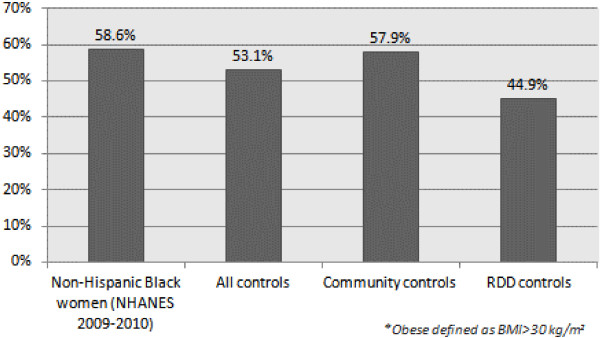
Percent obese among African American controls in WCHS vs. NHANES 2009–2010 rates (pre- and post-menopausal women combined).